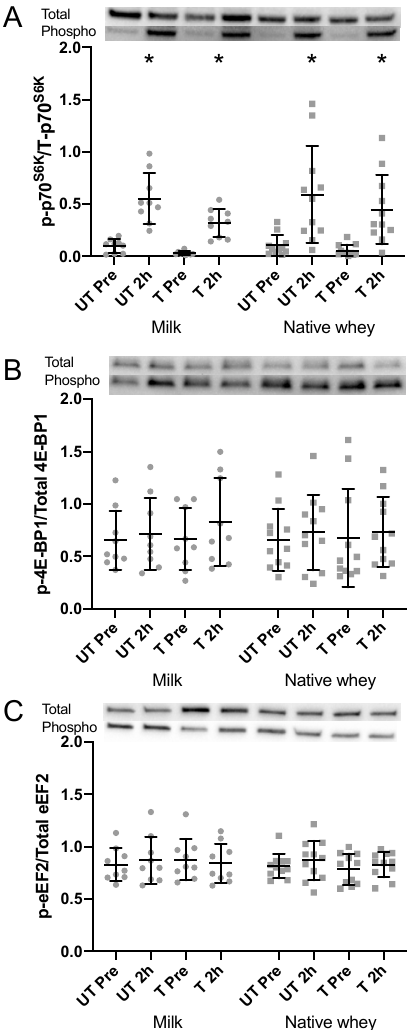
Figure 6. Phospho / total ratio of P70S6K ( A ), 4E-BP1 ( B ), and eEF-2 ( C ) following intake of milk and native whey immediately after a bout of resistance exercise in the elderly. UT: untrained; T: trained. Values are mean ± SD. n = 9 and 11 in the milk group and native whey group, respectively. Data were analyzed with a two-way repeated measures ANOVA (time × supplement). Multiple comparisons tests were used as post-hoc tests to specify the significant di ff erences between groups (Sidak) and time points within groups (Tukey). Relative changes were analyzed with a Student’s t test for di ff erences between pre and 2 h within groups (paired) and between groups (un-paired). * di ff erent from pre within group, p < 0.05.